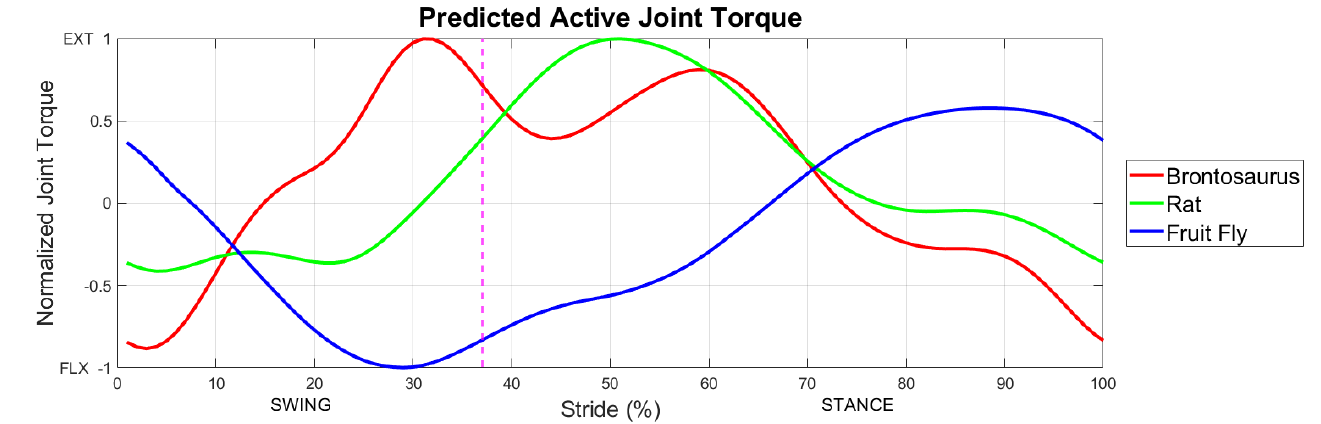
Figure 9. Predicted active joint torque for a rat as large as a brontosaurus [40–42] and as small as a fruit fly based on the scaling rules presented.